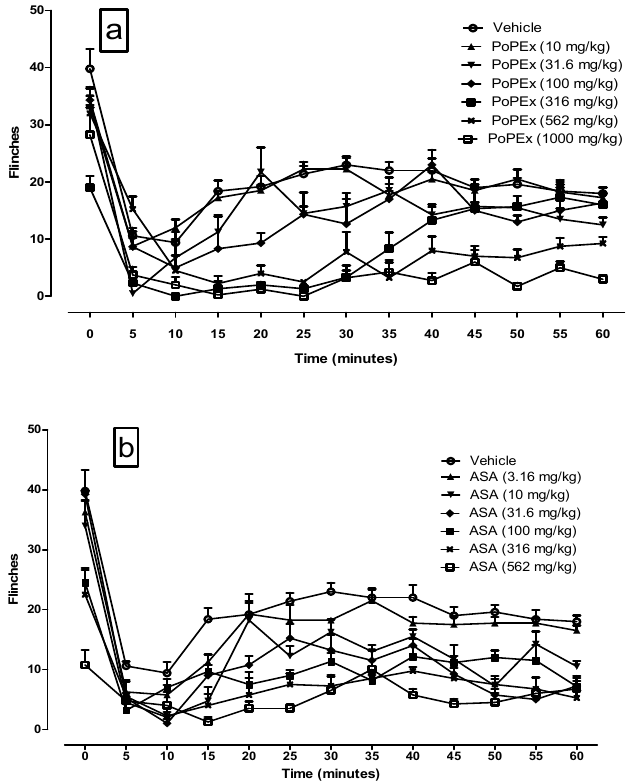
Figure 1. Time course of pomegranate peel extract ( a ) and acetylsalicylic acid ( b ) on the number of formalin-induced paw flinches every 5 min for 1 h. Thirty minutes before the formalin administration, the rats were pretreated with vehicle, ASA, or PoPEx at six different dose in logarithmic increments. The value of p ( < 0.05) was not indicated in the figures due to the saturation of lines, however, the statistical differences of the mean ± EE of each measurement time ( n = 6) in phase 1 were minimal and began to manifest at from the dose of 316 mg for both PoPEx and ASA, and with regard to phase 2, PoPEx began to have a significant effect from 316 mg/kg and ASA from 10 mg/kg weight.